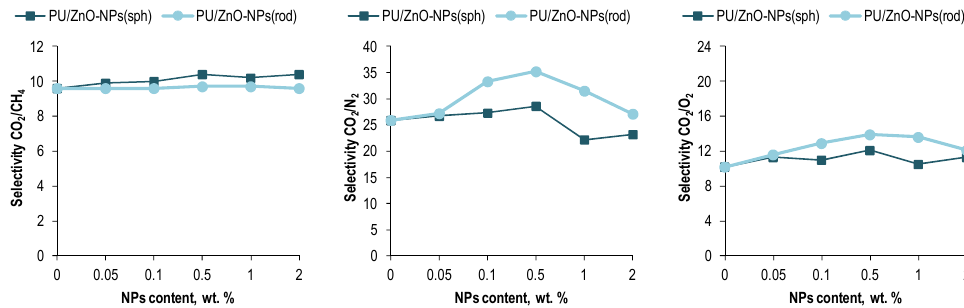
Figure 7. The selectivity of the polymeric membranes based on the PU/ZnO-NPs.